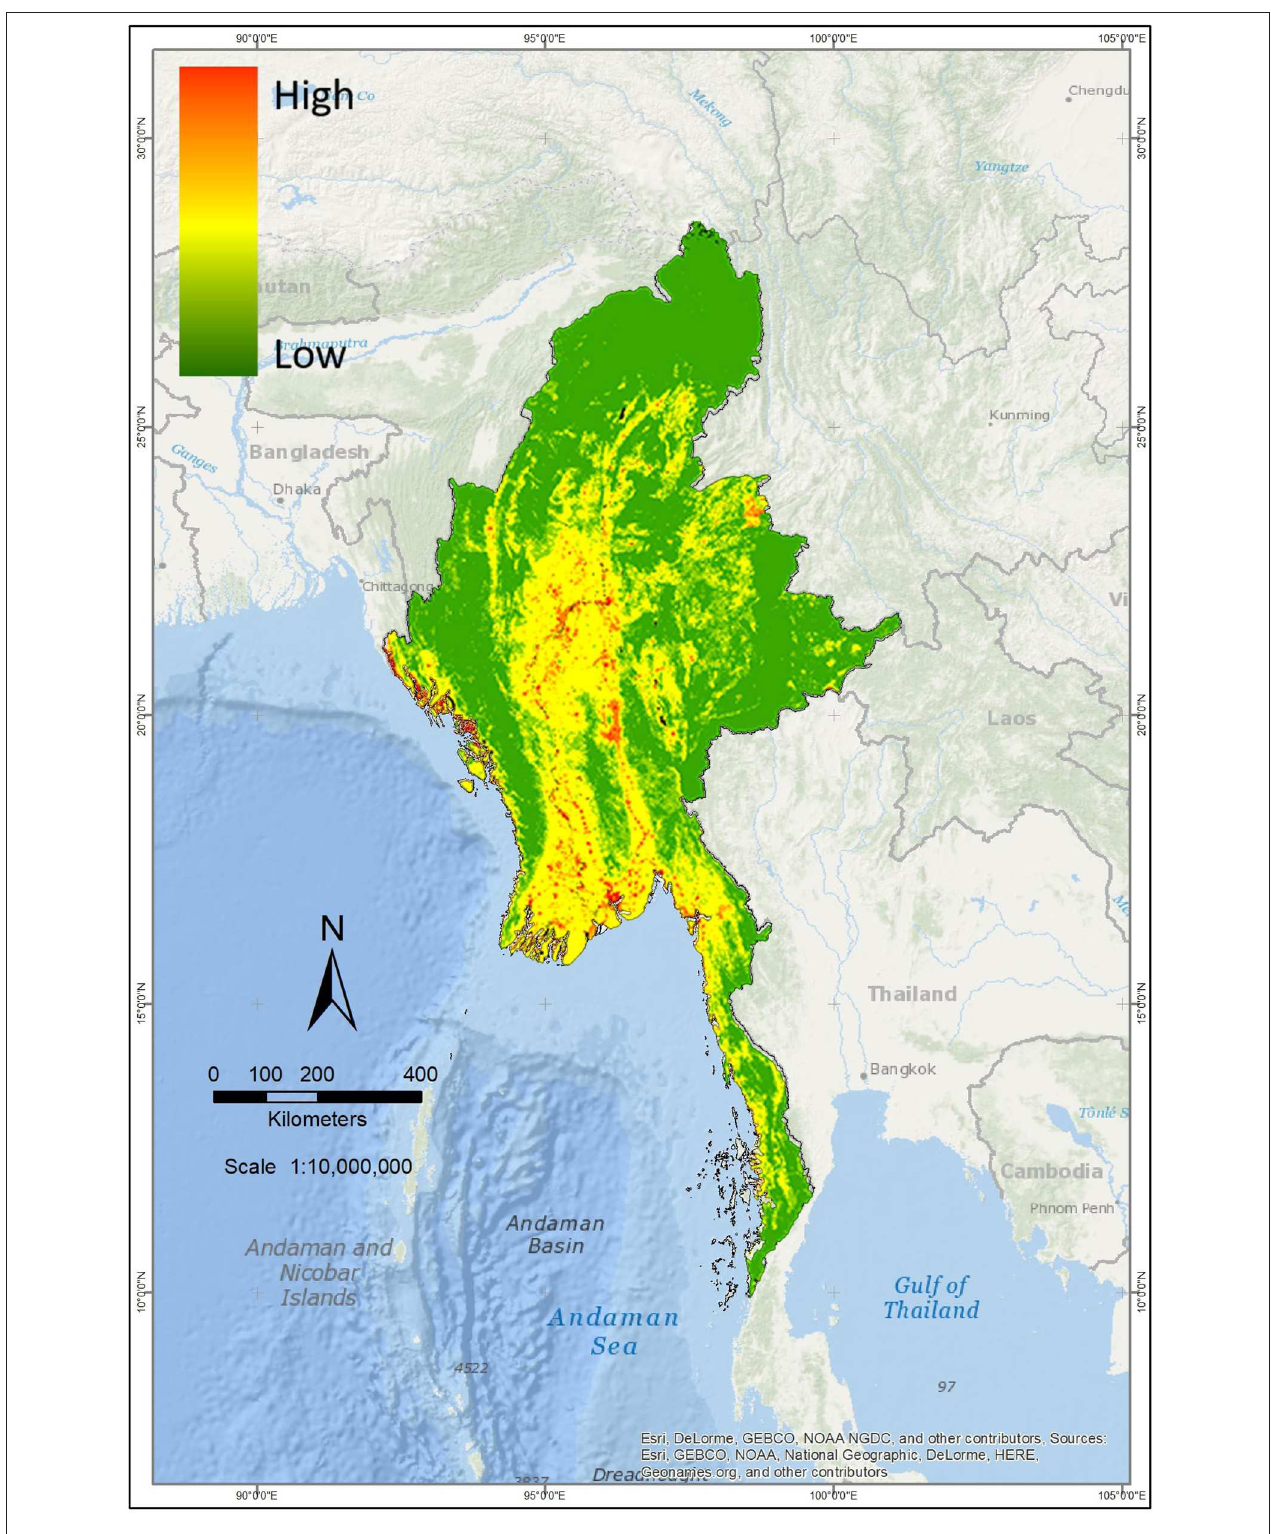
FIGURE 6 | Flood exposure map of Myanmar. Flood exposure includes land cover, infrastructural, and population data.